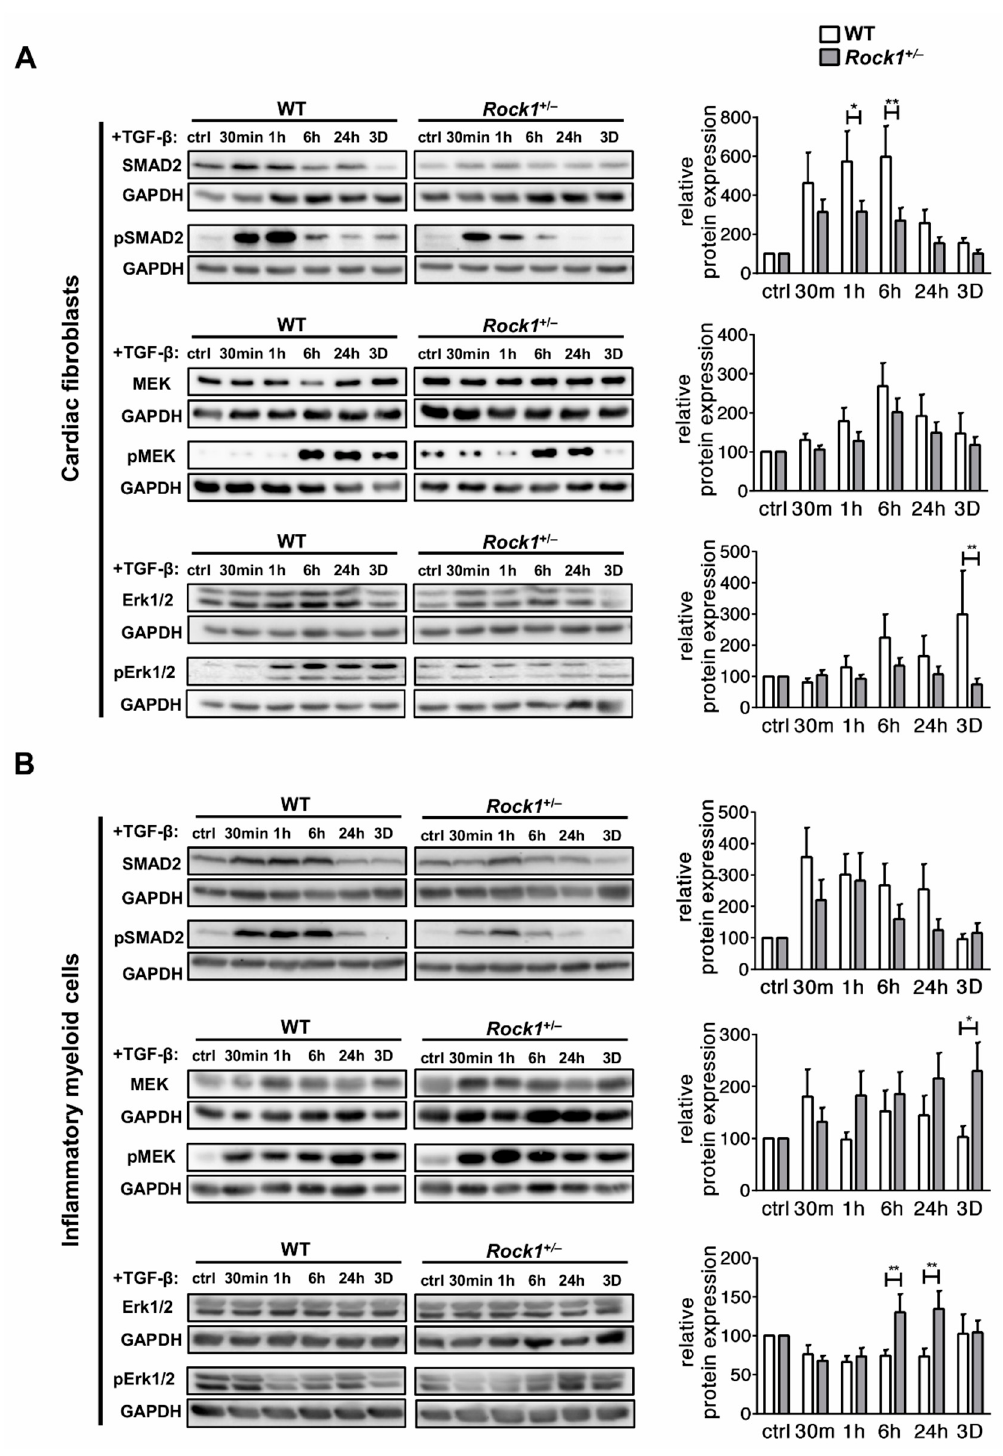
Figure 4. Differential molecular response of wild-type and Rock1 +/ − cardiac fibroblasts and inflammatory myeloid cells to TGF- β Representative immunoblots and the respective quantifications of Smad2 activation (pSMAD2/SMAD2), MEK activation (pMEK/MEK) and Erk activation (pErk/Erk) in wild-type and Rock1 +/ − cardiac fibroblasts ( A ) and inflammatory myeloid cells ( B ) at the indicated time point following TGF- β stimulation. Protein levels were normalized to GAPDH. Relative response to TGF- β was calculated in relation to internal untreated controls (ctrl) for wild-type and Rock1 +/ − cells. Bars represent mean value ± SEM. n = 6–7, * p < 0.05, ** p < 0.01 calculated with the unpaired Student’s t -test for each time point.